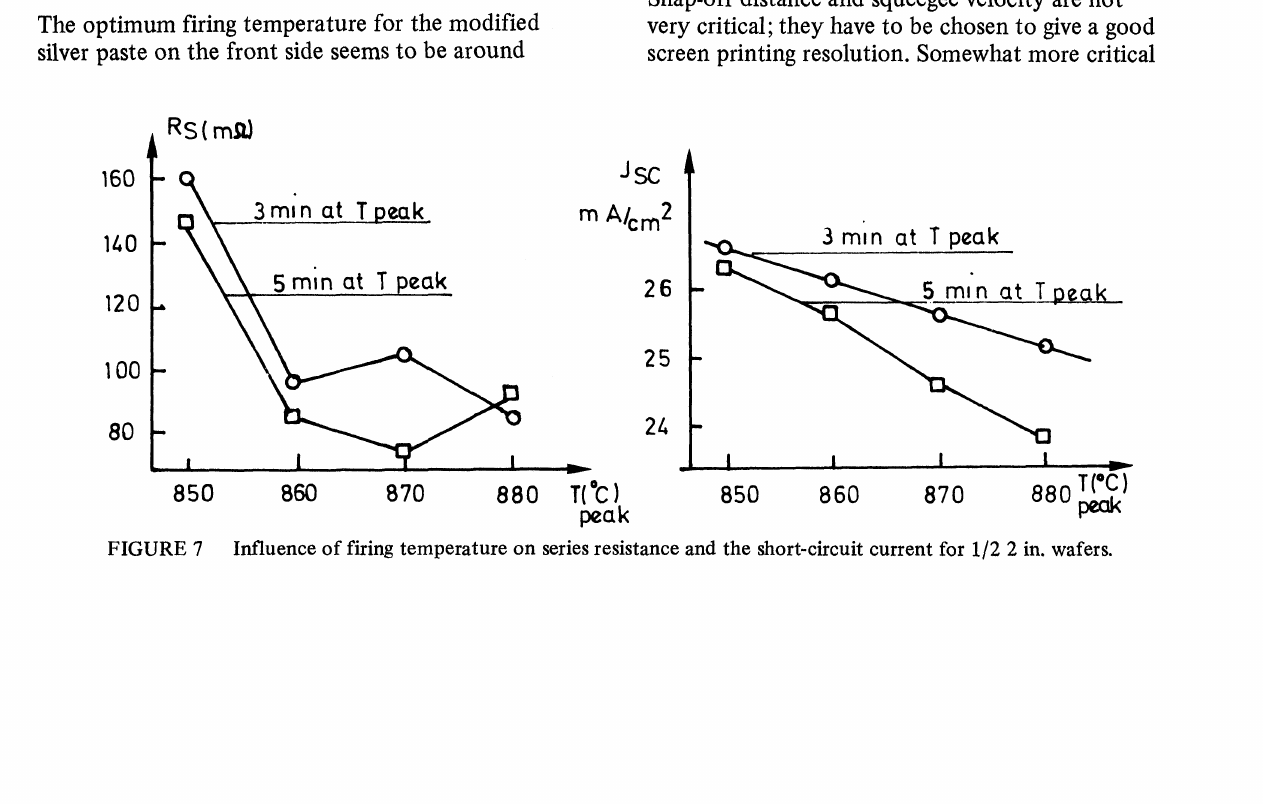
FIGURE 7 Influence of firing temperature on series resistance and the short-circuit current for 1/2 2 in.